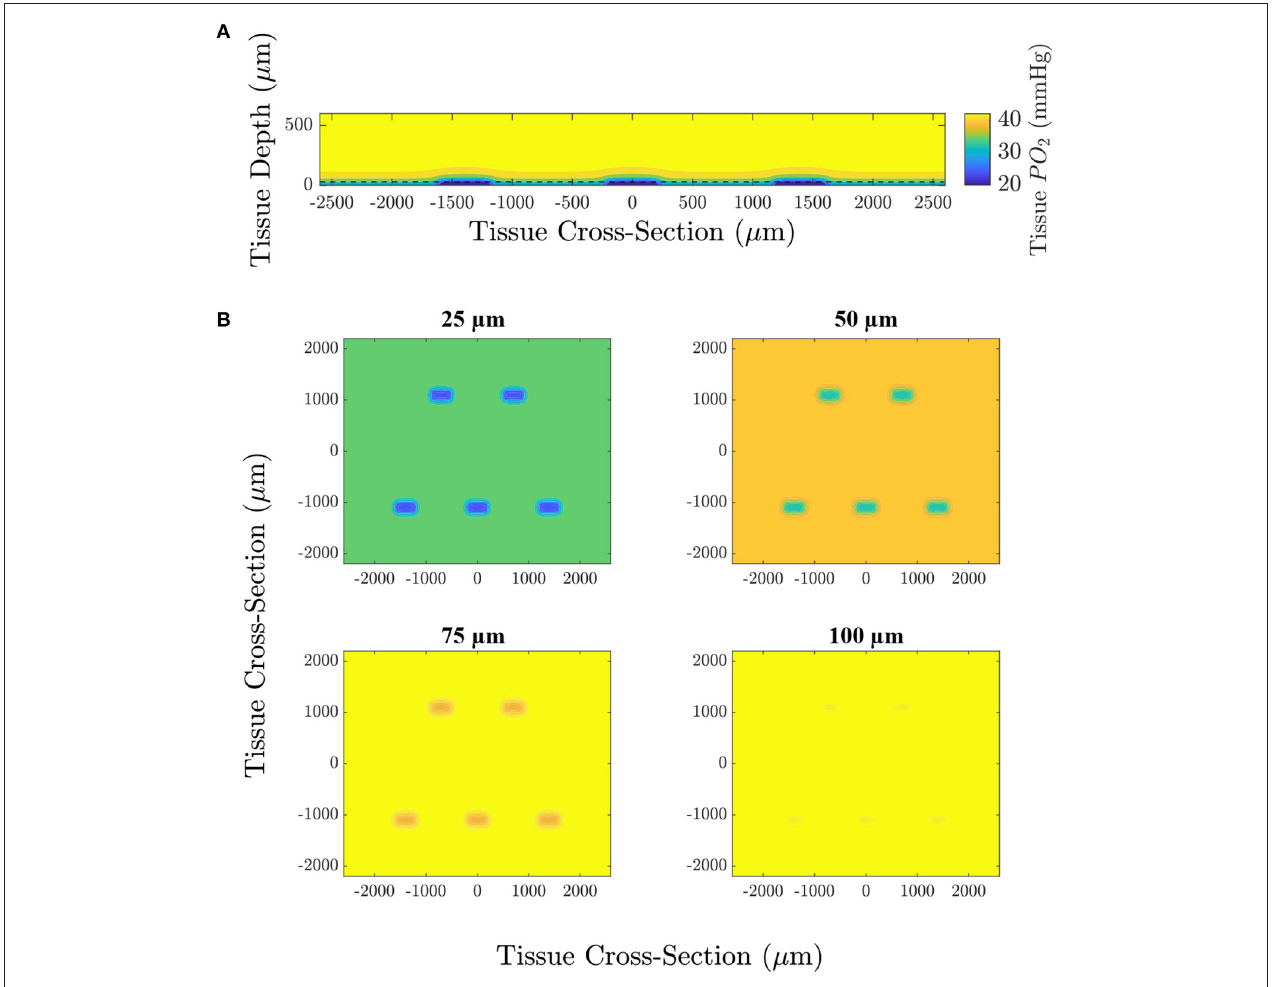
FIGURE 4 | Computational simulation predicting the tissue PO 2 resulting from diffusional exchange between the tissue and gas exchange chamber in response to a low O 2 challenge. Results are presented as a contour map of the steady-state O 2 distribution in the tissue around the gas exchange windows with a 25 µ m thick PDMS layer. (A) Section through the long axis of the window oriented normal to the imaging plane of the microscope. The dashed line indicates the position of the top of the PDMS layer. (B) Sections oriented with the imaging plane at depths of 25, 50, 75, and 100 µ m from the surface of the glass